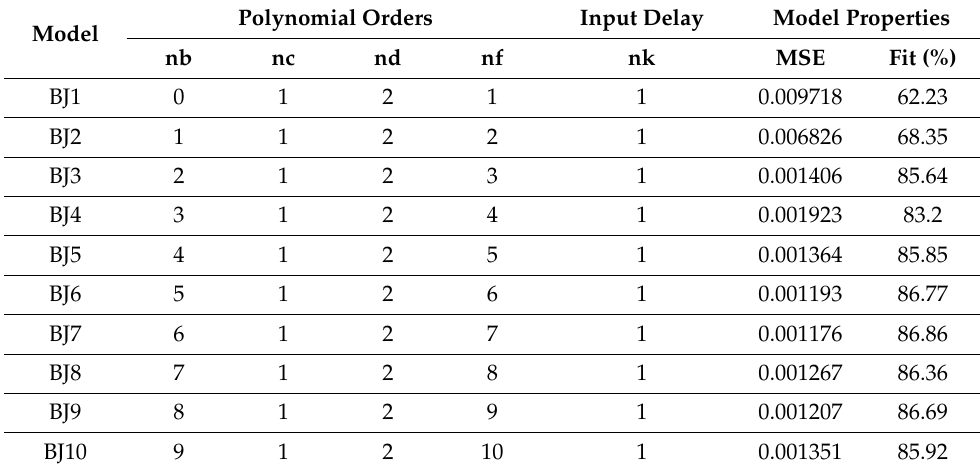
Table 2. Box–Jenkins polynomial model orders and